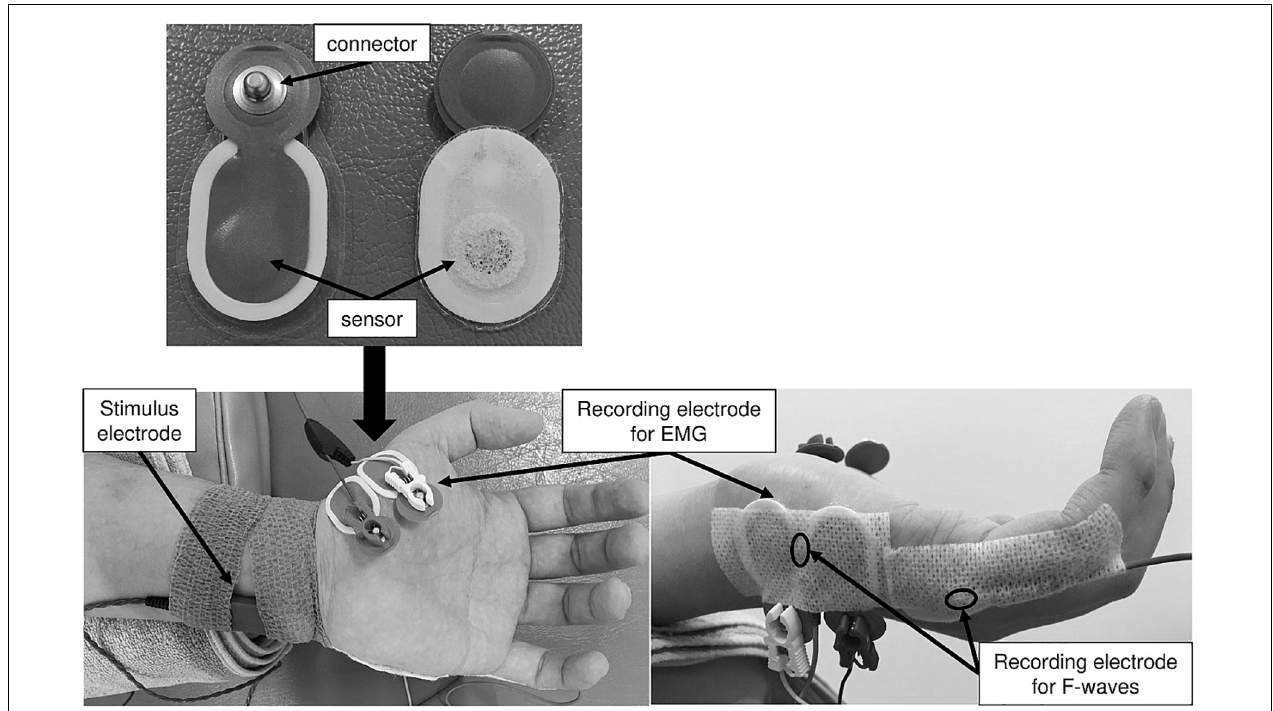
FIGURE 2 | The recording electrode arrangement for the ME and MI task. These figures show placement of stimulus and recording electrodes for the ME and MI tasks.